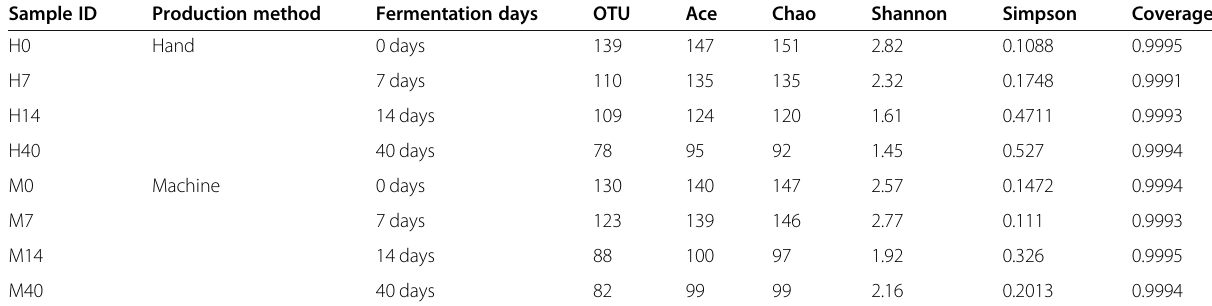
Table 1 Microbial community richness and diversity indices of the 16S rRNA sequences for clustering at 97% sequence similarity from all samples of Daqu H and Daqu M Sample